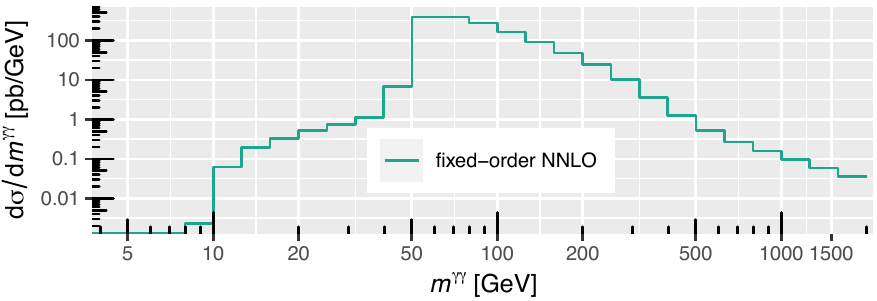
> 25 GeV , q γ, 2 > 22 GeV and T T